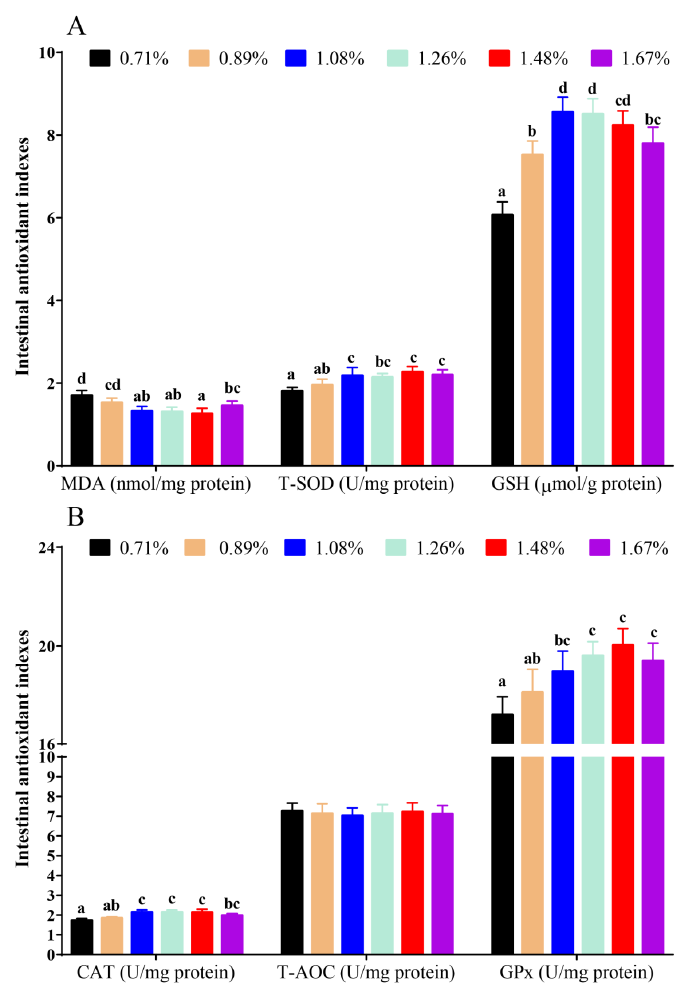
Figure 1. The results of intestinal MAD and antioxidant indexes against graded different levels of dietary histidine. ( A ) showed the results of MDA, T-SOD and GSH, ( B ) showed the results of CAT, T-AOC and GPx. Data are presented as mean ± standard deviation ( n = 3 × 3). Values with different alphabetical superscripts above bars are significantly different ( p <